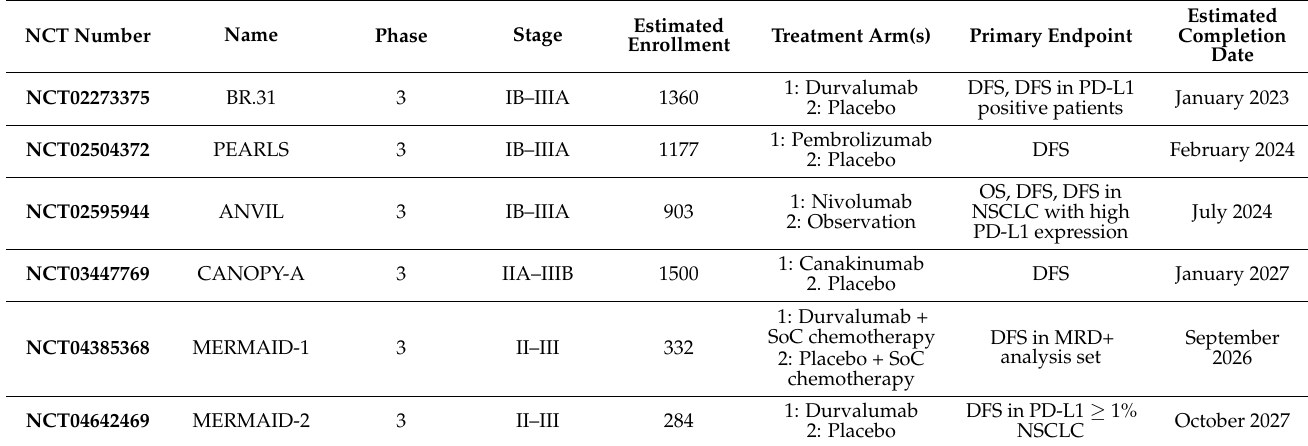
Table 4. Ongoing clinical trials that included adjuvant immunotherapy in resected